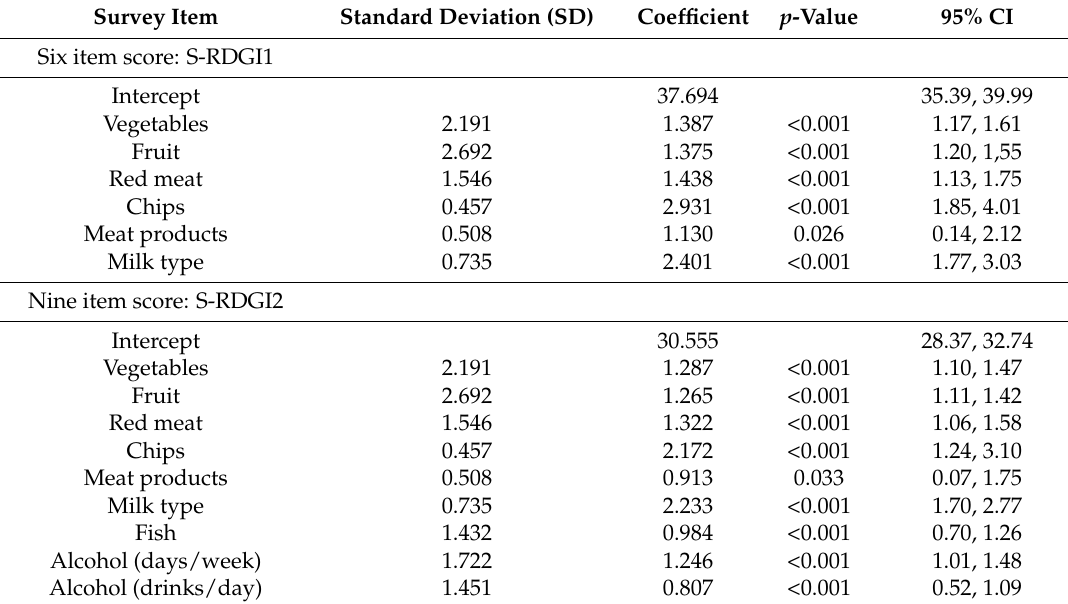
Table 3. Estimated coefficients from the fitted linear regression models for prediction of S-RDGI